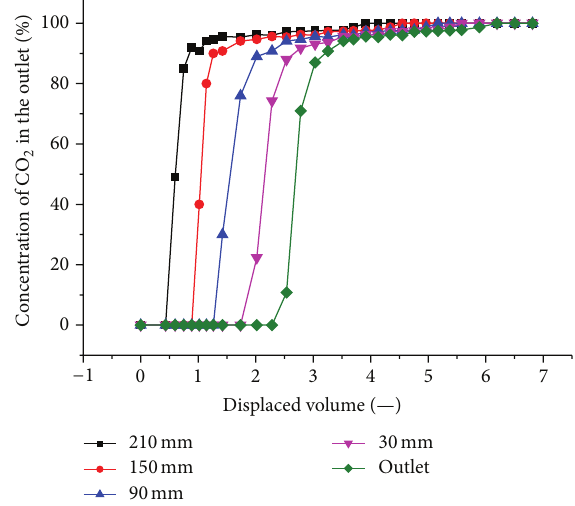
Figure 14: CO 2 concentration versus time sampled from various locations along the length of the coal pack. The injection pressure of CO 2 was maintained at 1.5